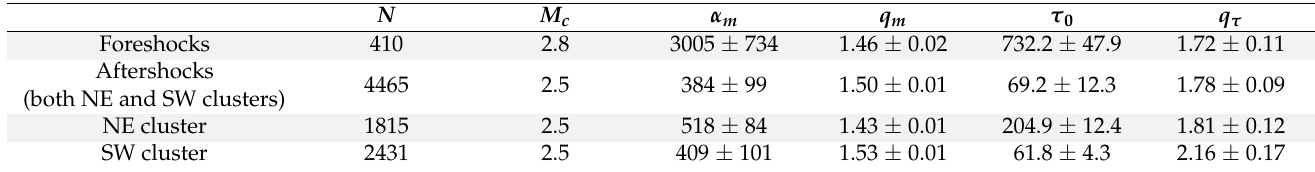
Table 6. Parameter values for the foreshock and aftershock sequences in Arkalochori, as well as for the NE and SW aftershock clusters. N is the number of events (with M ≥ M c ), Mc the magnitude of completeness, a m , q m the parameters of the NESP model (Equation (6)) and τ 0 , q τ the parameters of the q -exponential function for the inter-event time distribution (Equation (10)). N M